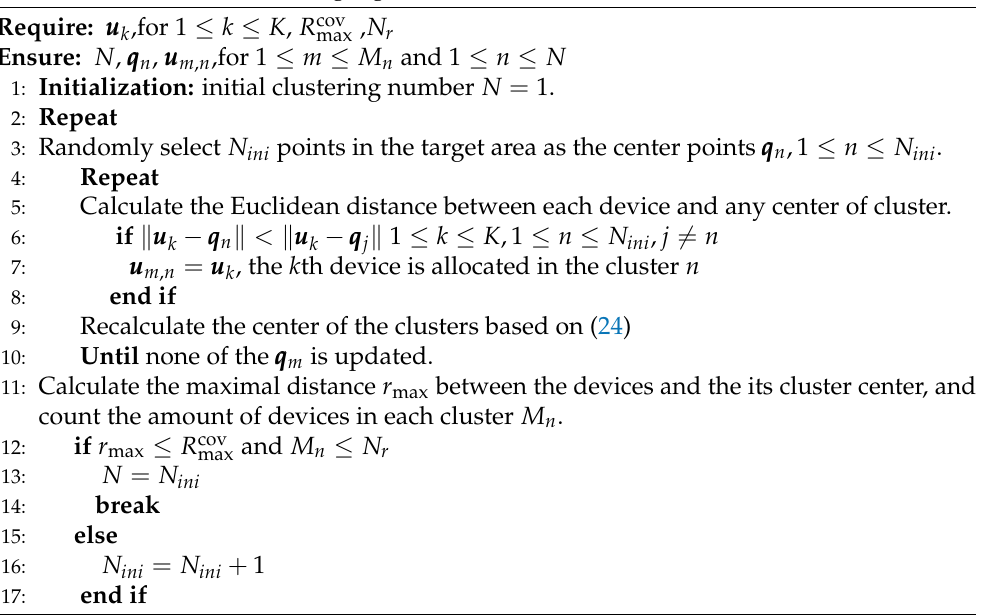
Algorithm 1 The proposed solution of the UAV trajectory and user clustering with an incremental K -means clustering